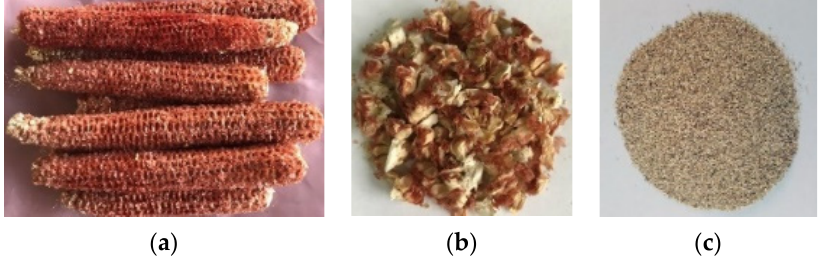
Figure 1. Images of corn cobs biomass (CCB) ( a ) as received; ( b ) crushed; ( c ) sieved ( ≤ 0.25 mm). The washed CCB was filtered through a filter funnel, the separated solid was washed with distilled water until the filtrate was neutral to pH and was dried at 110 °C for 4 h, and the resulting material was labeled as pretreated corn cob biomass